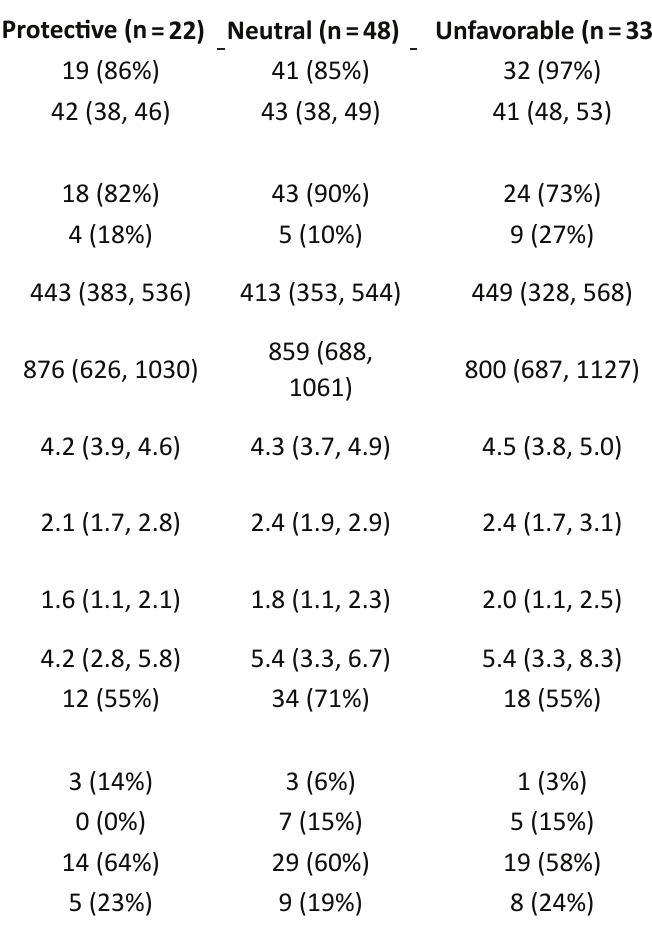
Supplementary Table 2. Baseline characteristics for HLA-B groups